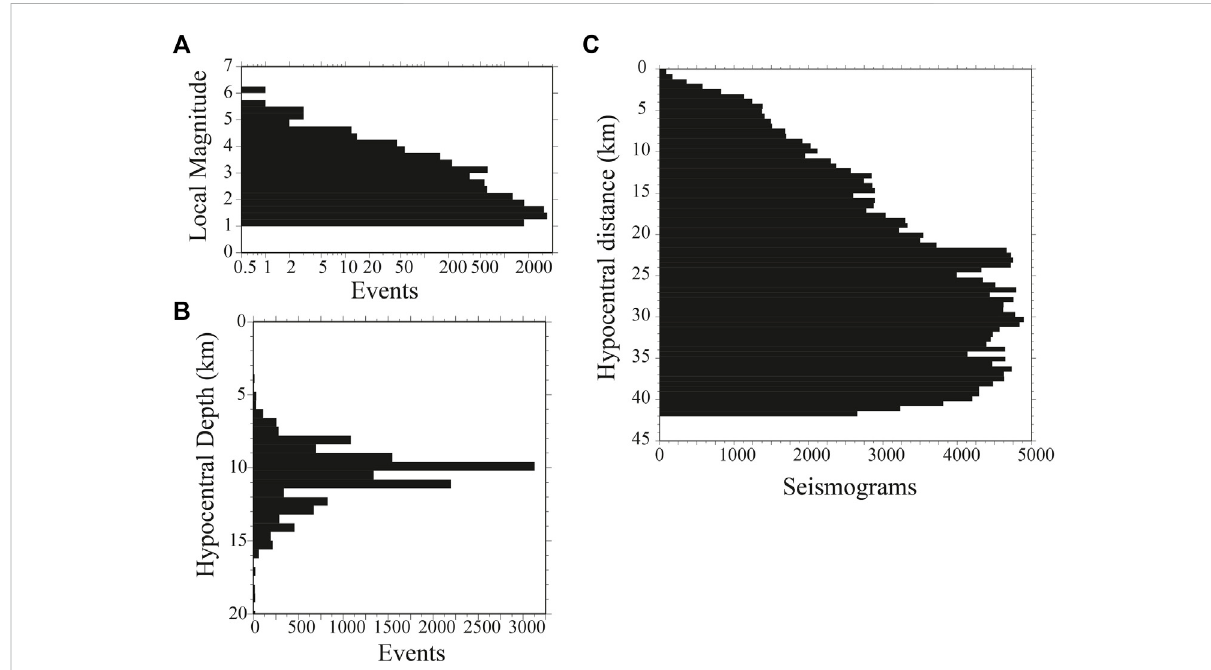
FIGURE 2 Histograms describing our data set: (A) local magnitudes (M L ); (B) hypocentral depths, relative to free surface; (C) source-receiver hypocentral